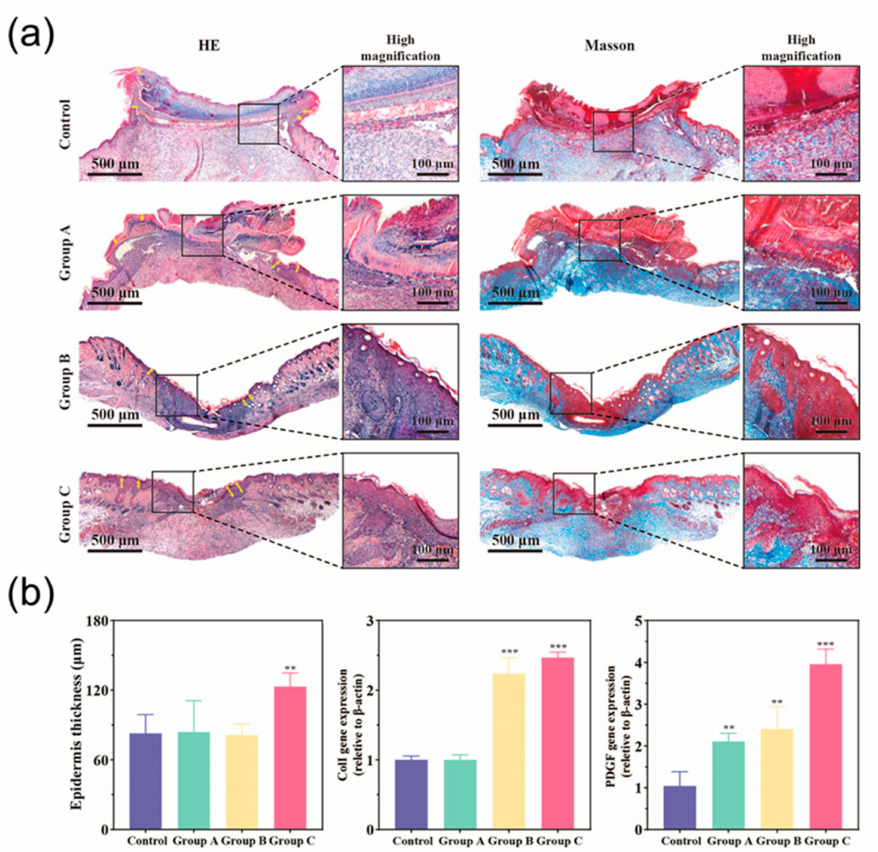
Figure 6. ( a ) H&E and Masson staining for different treatments and periods. The scale bar is 500 µ m. ( b ) Pathology index: epidermis thickness, coll gene expression and PDGF gene expression measured by qPCR. Data shown as mean ± SD. n = 4 per group. ** means p < 0.01, and *** means p < 0.001.